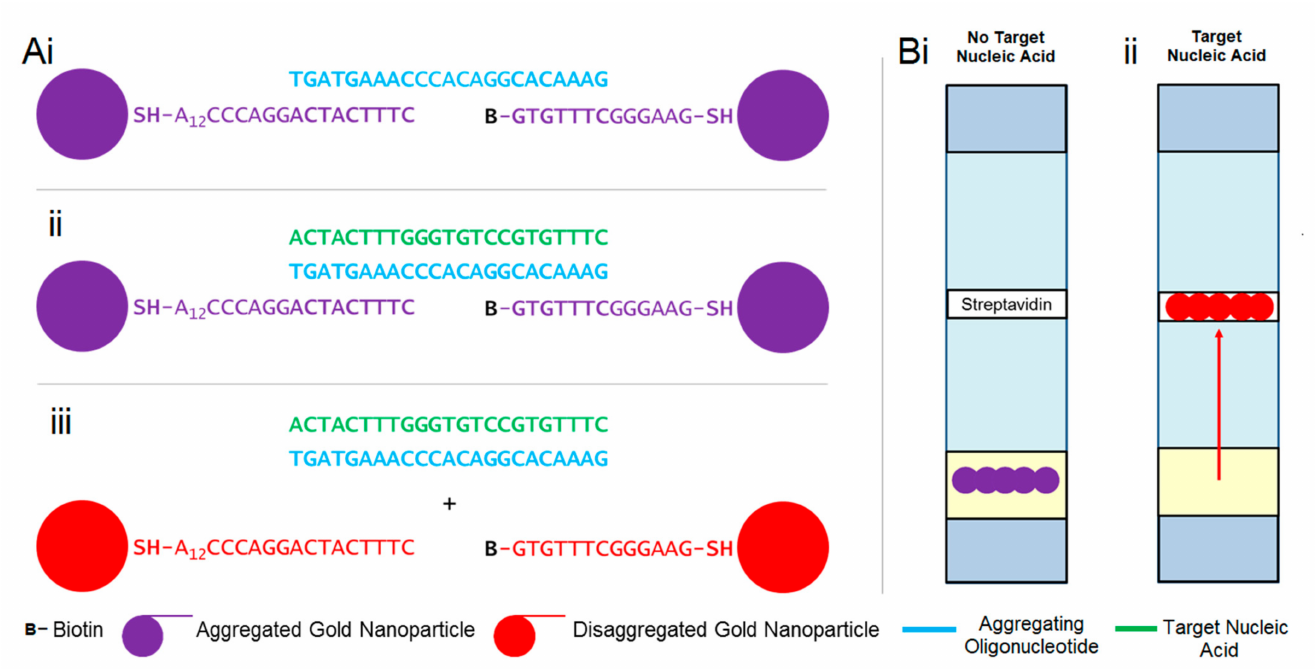
Figure 1. Diagrammatic representation of signal transduction mechanisms of gold–oligonucleotide nanoconstructs using ( A ) colourimetric response and ( B ) differential binding. (Ai) Oligonucleotide 5 (cid:48) GA AAC ACG GAC ACC CAA AGT AGT 3 (cid:48) aggregates nanoparticles functionalised with Sequence A (SH-5 (cid:48) A 12 CCC AGG ACT AC T TTC 3 (cid:48) ) and Sequence B (Biotin—5 (cid:48) GTG TTT CGG GAA G 3 (cid:48) —SH). (Aii) Target nucleic acid hybridises with oligonucleotide and (Aiii) disaggregates gold nanoparticles to produce a visual and spectroscopic colour change from purple to deep red. (Bi) Aggregated particles do not move upon lateral flow in the absence of target nucleic acid. However, in the presence of (Bii) target nucleic acid, gold particles are disaggregated and able to flow on lateral flow membranes and bind streptavidin because of biotin